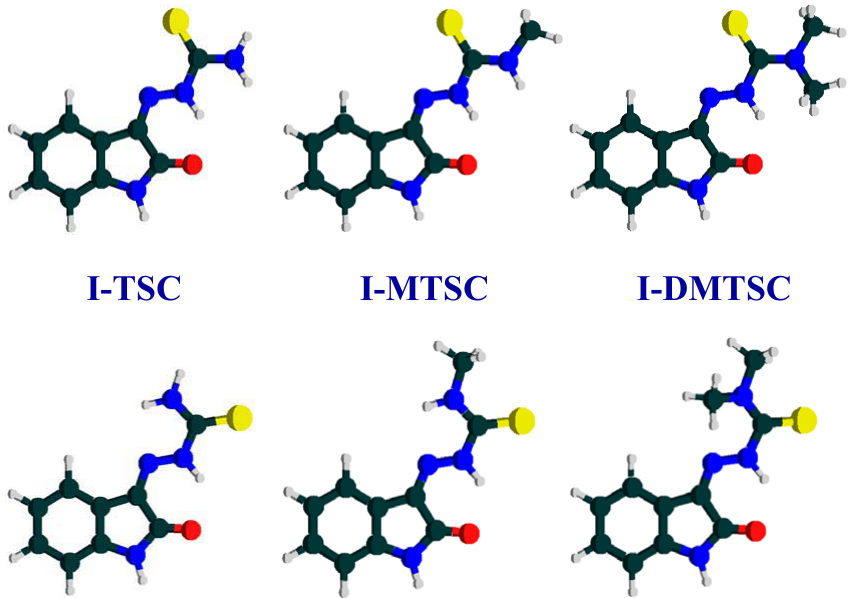
Fig. 2 Optimized structures of isatin-based